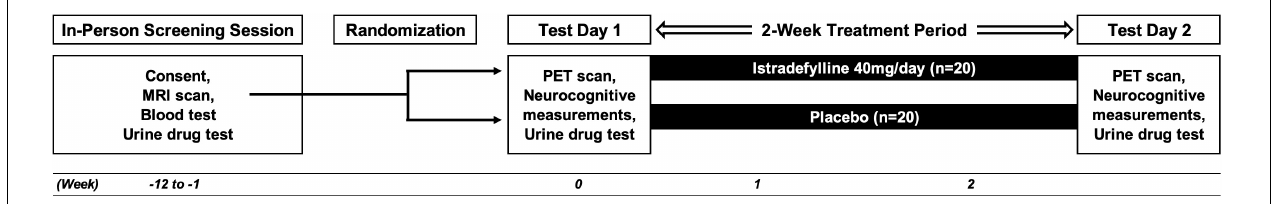
FIGURE 1 | Schematic diagram of the study.